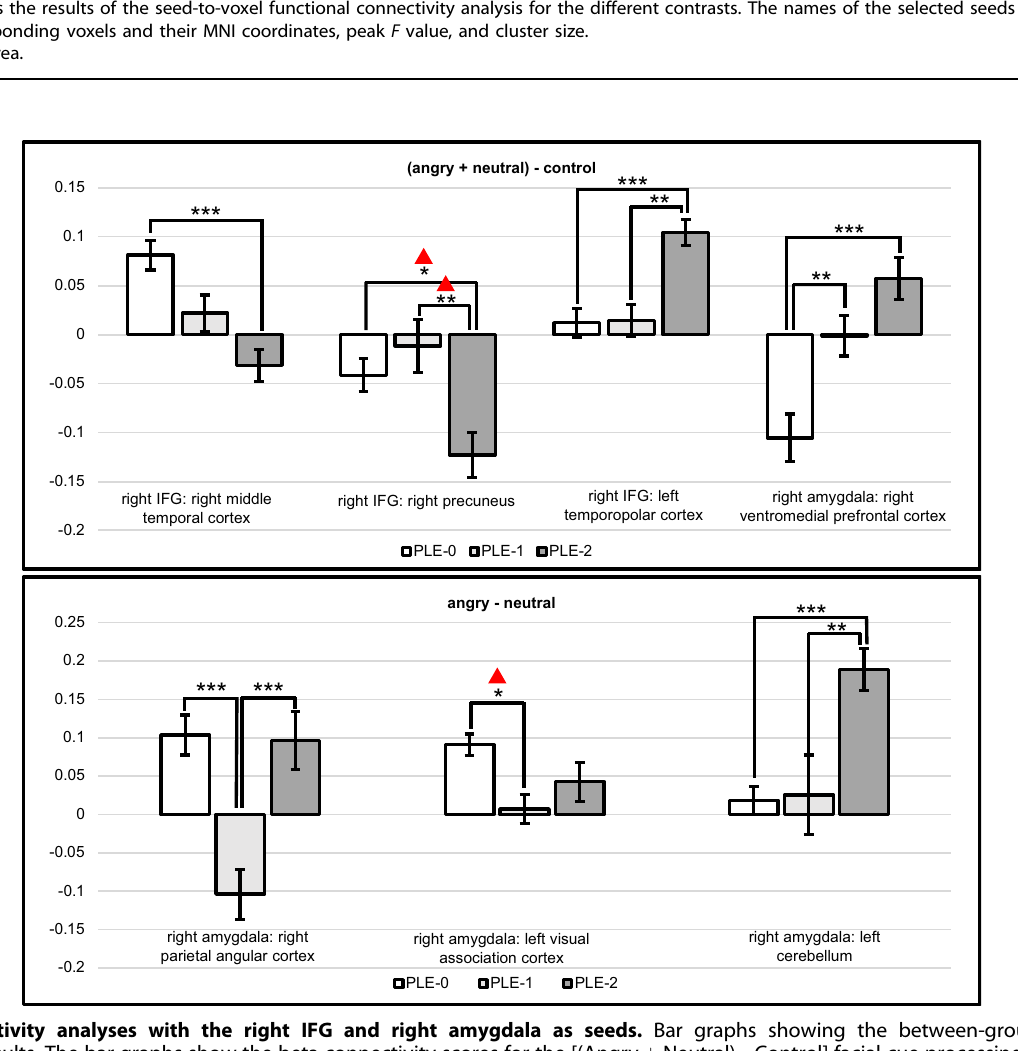
Fig. 2 Connectivity analyses with the right IFG and right amygdala as seeds. Bar graphs showing the between-group functional connectivity results. The bar graphs show the beta connectivity scores for the [(Angry + Neutral) – Control] facial cue processing contrast and the (Angry − Neutral) negative emotion processing contrast for the three trajectories (PLE-0 = control trajectory; PLE-1 = decreasing trajectory; PLE-2 = increasing trajectory). * p < 0.05, ** p < 0.01, *** p < 0.001. Not signi fi cant after applying a Bonferroni correction for the number of seeds (p <